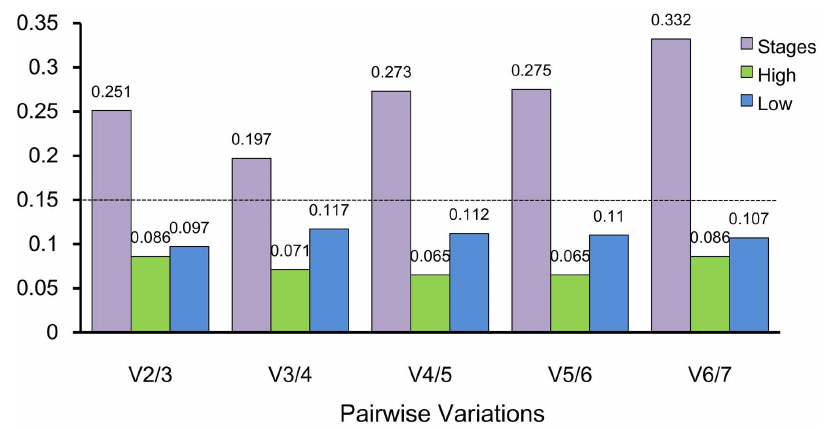
Figure 3. Optimal number of reference genes for normalization in Frankliniellaoccidentalis. The pairwise variation (Vn/Vn + 1) was analyzed between normalization factors NFn and NFn + 1 by geNorm program to determine the optimal number of reference genes. Values , 0.15 indicate that additional genes are not required for the normalization of gene expression.